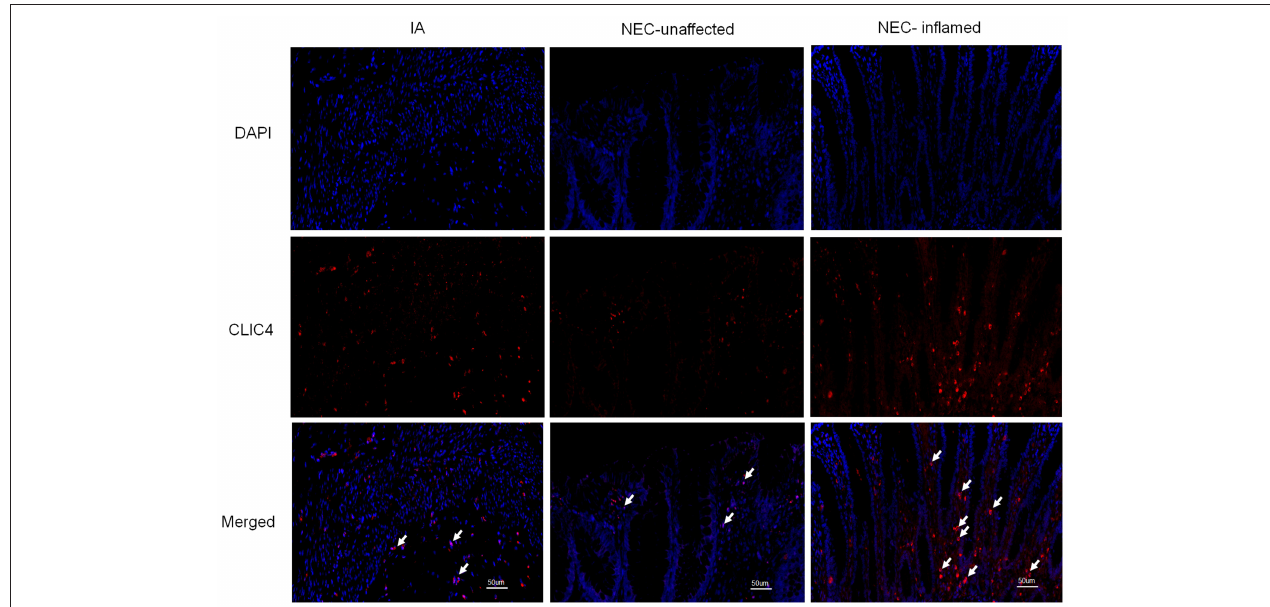
FIGURE 5 | CLIC4 expression level in the intestines of children with intestinal atresia and NEC. IA, intestinal atresia; NEC-unaffected, NEC patients’ unaffected intestinal samples; NEC-inflamed, NEC patients’ inflamed intestinal